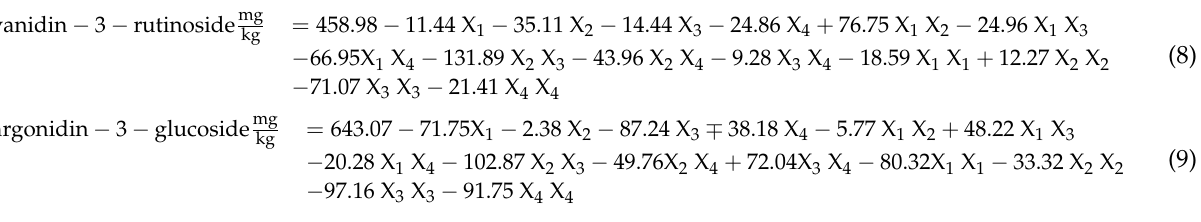
Table 3. Results of ANOVA of the reduced models giving significant and non-significant